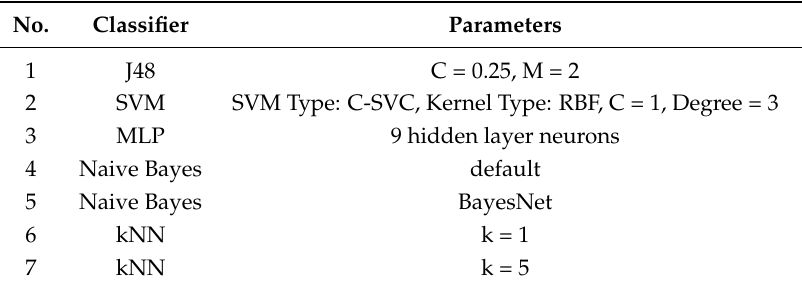
Table 6. Tested machine learning